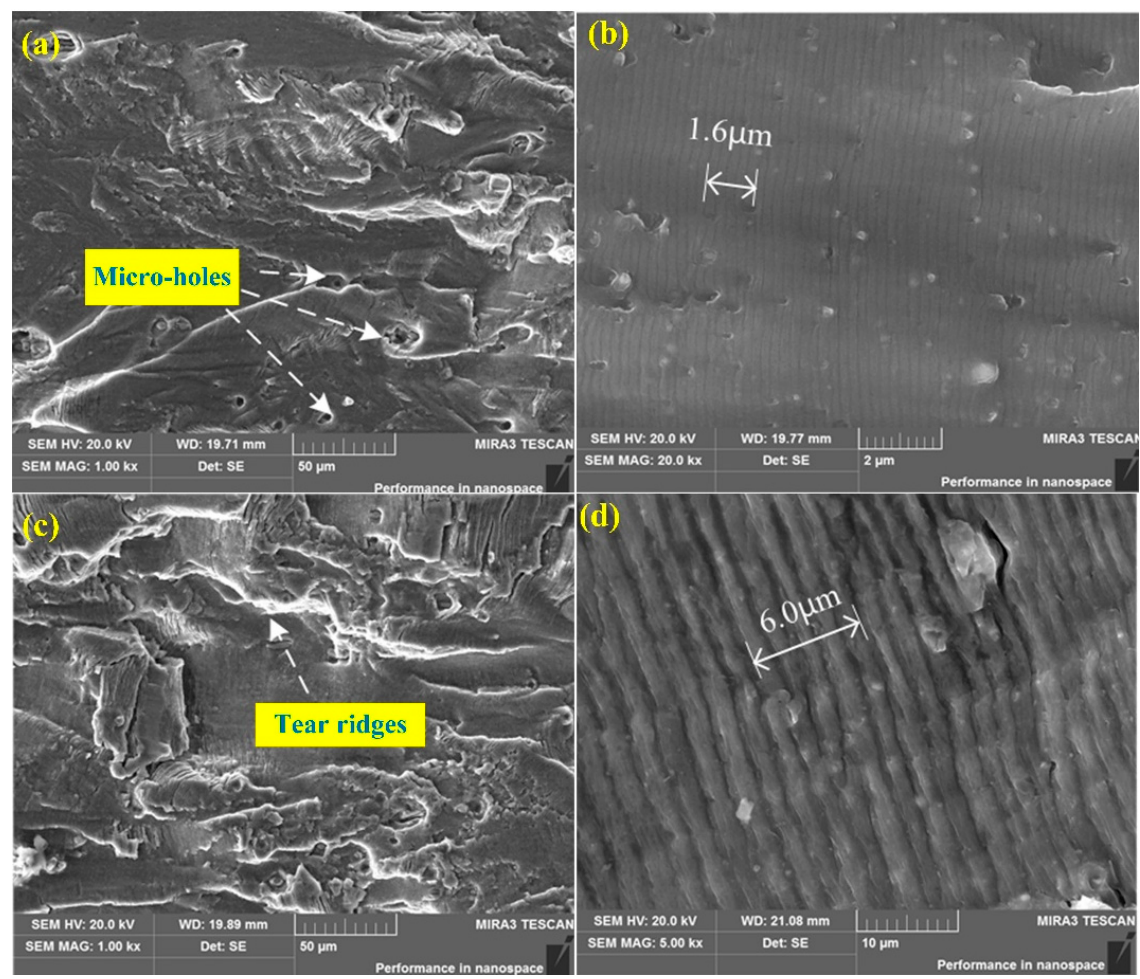
Figure 8. SEM images of stable crack propagation zone: ( a , b ) 3 mm from the crack initiation end; ( c , d ) 10 mm from the crack initiation end.